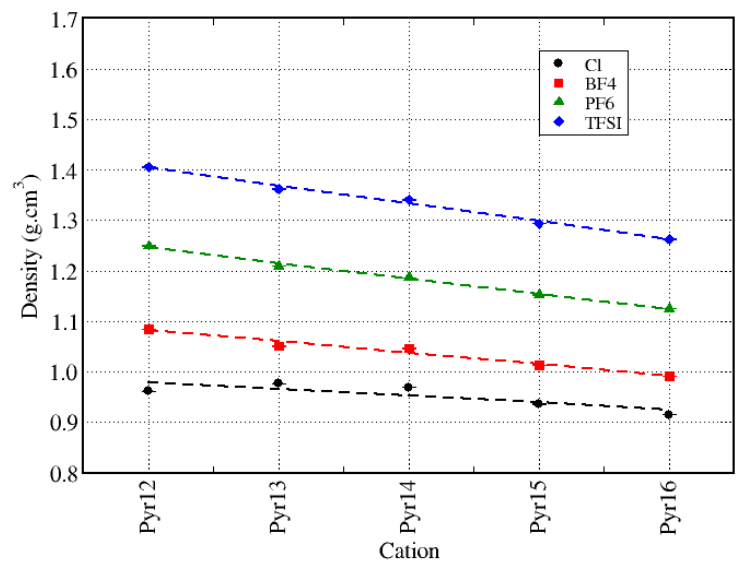
Figure 2. Density of the neat ionic liquids as a function of the size of the pyrrolidinium aliphatic chain, for all